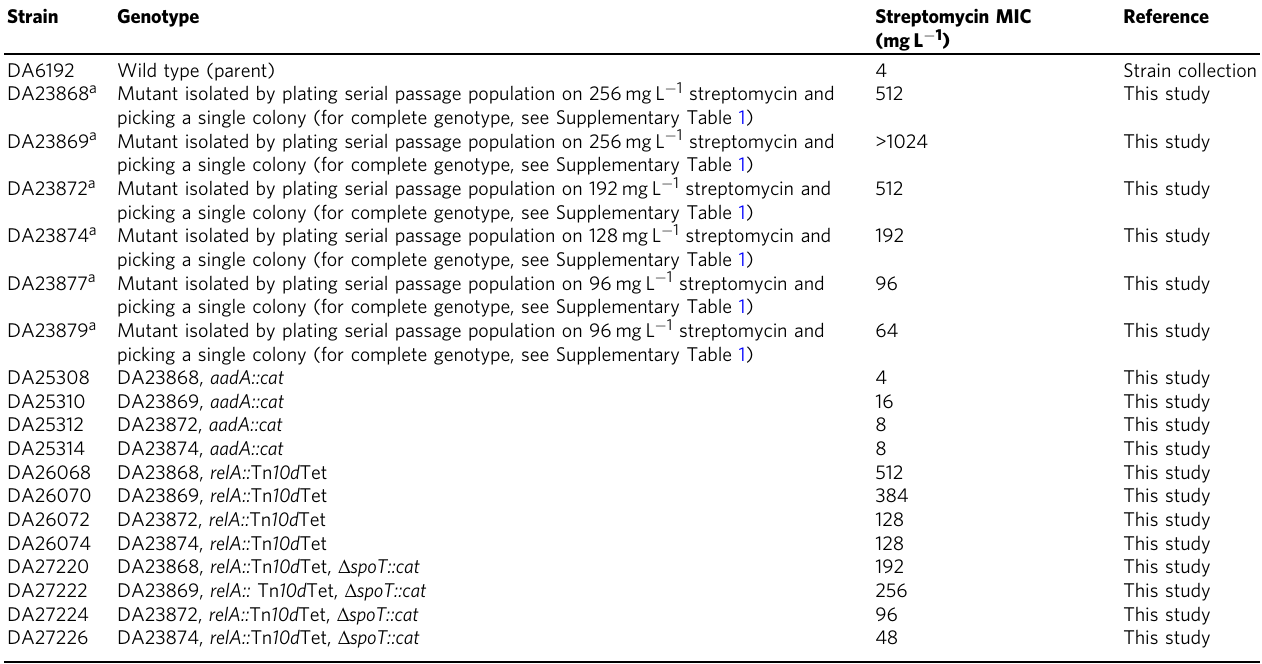
Table 1 Isolated resistant mutants Strain